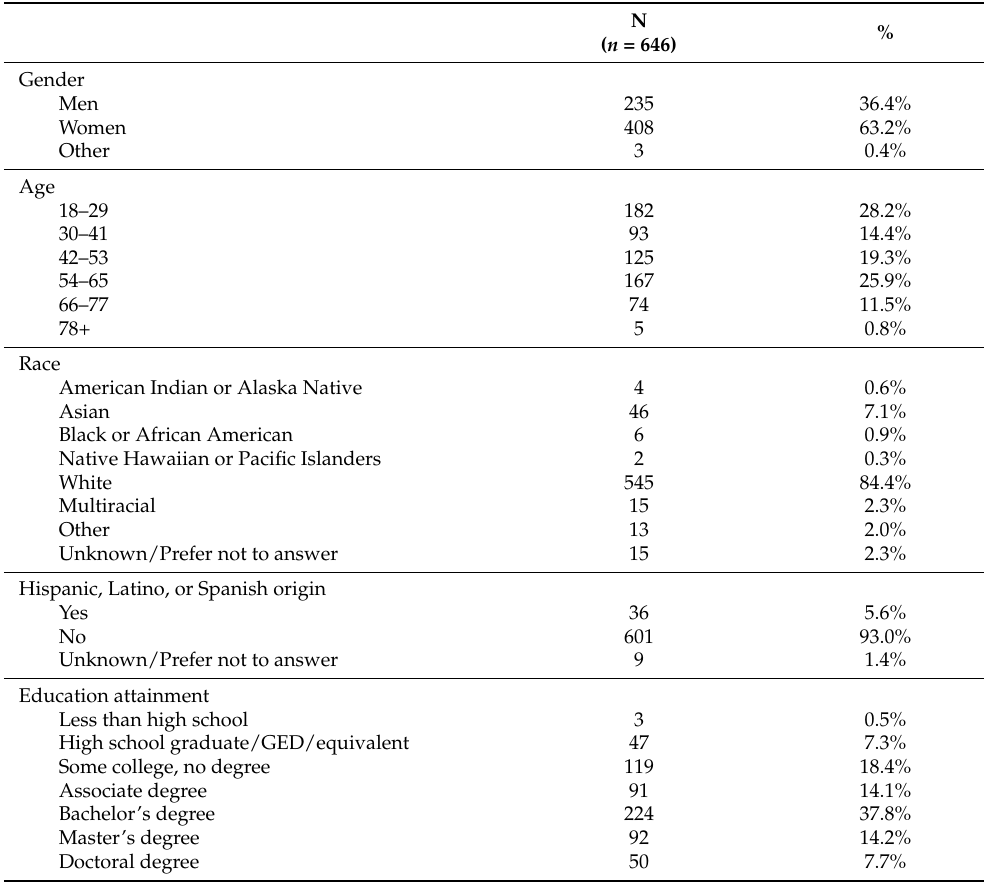
Table 2. Participant demographic